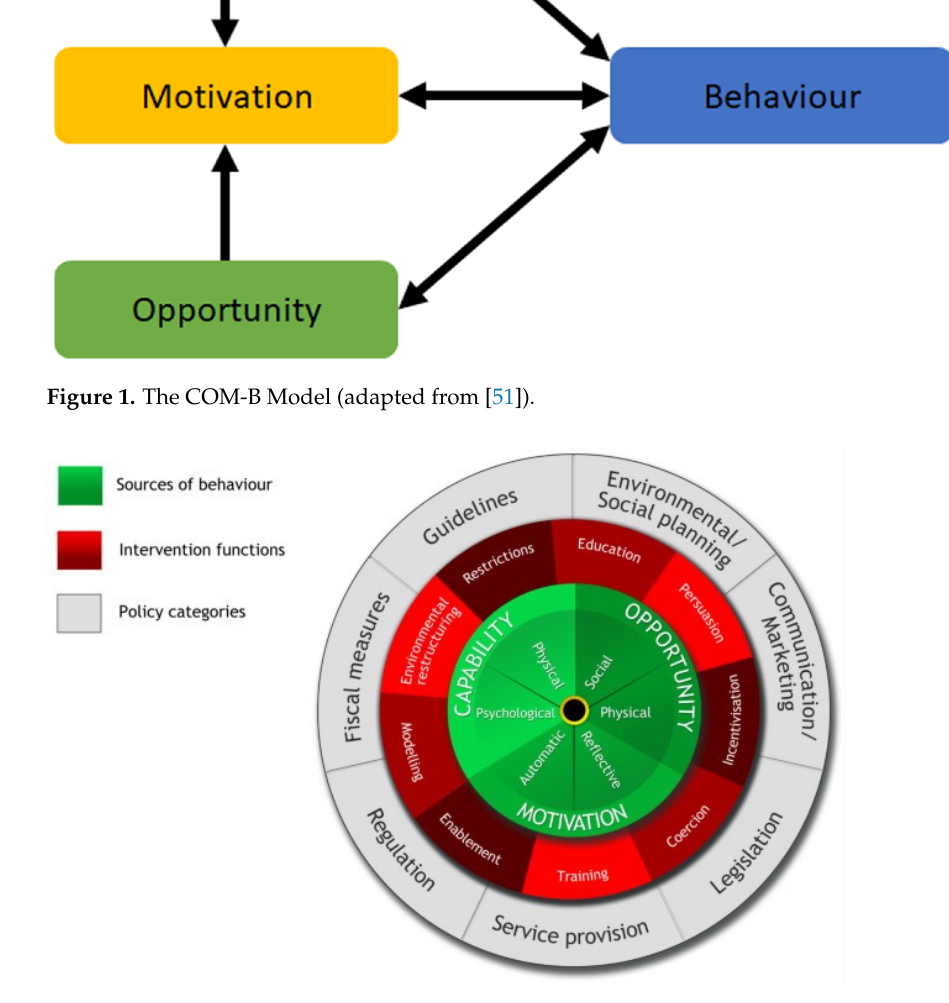
Figure 2. The Behaviour Change Wheel [53].